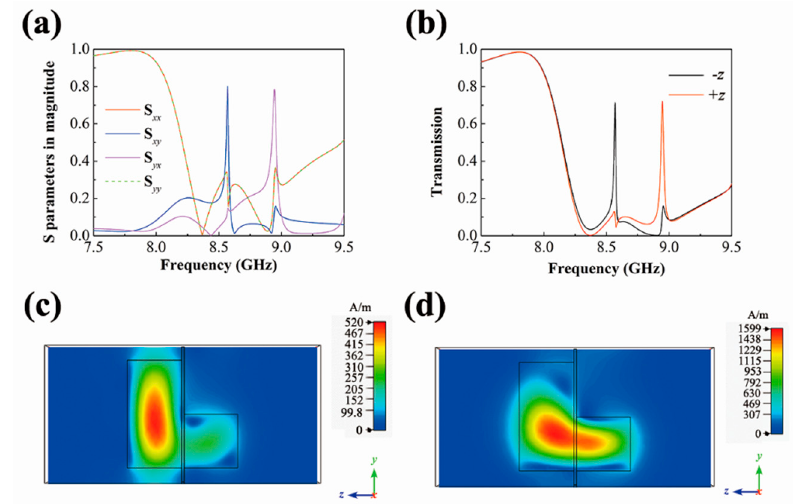
Figure 3. ( a ) Simulated spectra of the four S-parameters. ( b ) Calculated transmissions in the - z and the + z directions. Simulated magnetic field | H | at 8.571 GHz in the y - z plane under a ( c ) x -polarized and ( d ) y -polarized incident wave.